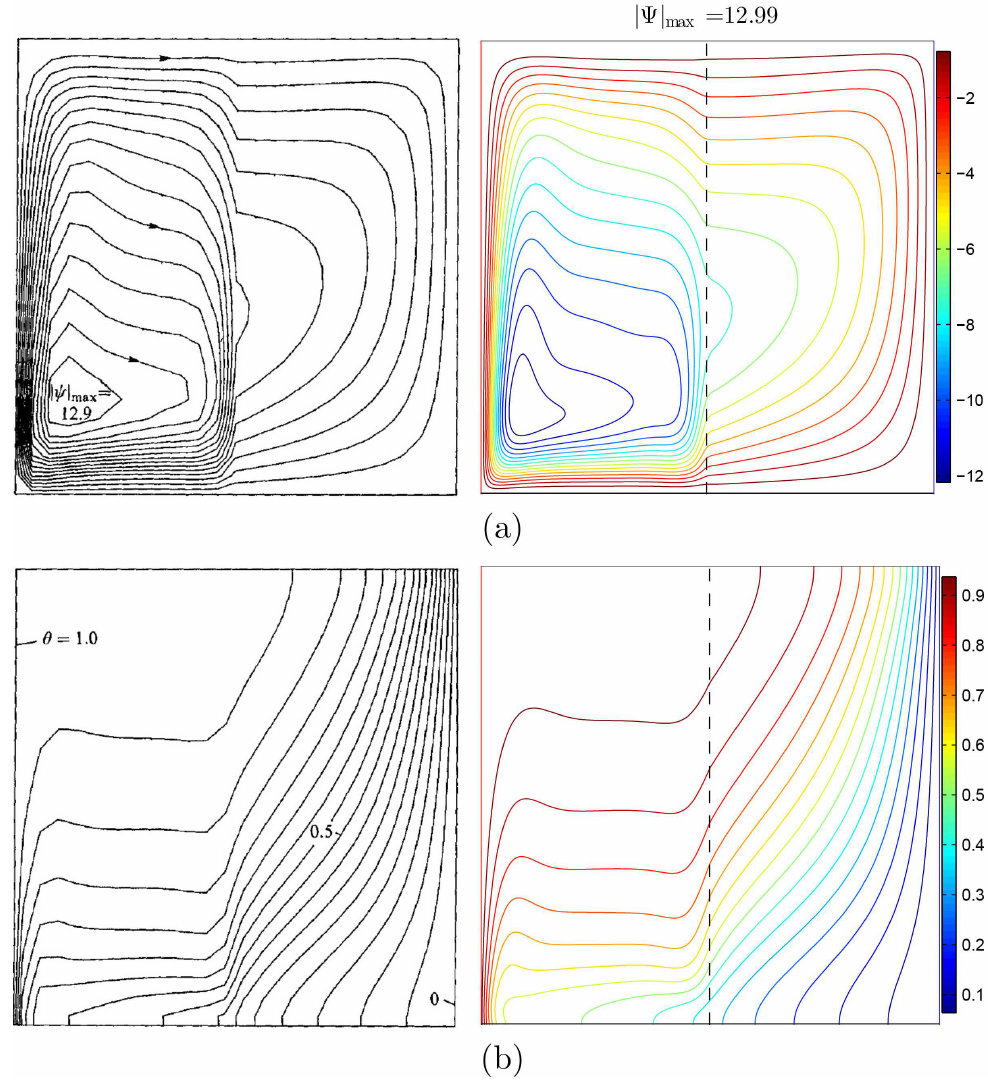
Figure 3. ( a ) Streamlines of Beckermann et al. [6] ( left ) and the present study ( right ); ( b ) isotherms for Ra = 3.70 × 10 6 , Da = 1.370 × 10 − 5 , ε = 0.9, D = 0.5 N = 0,